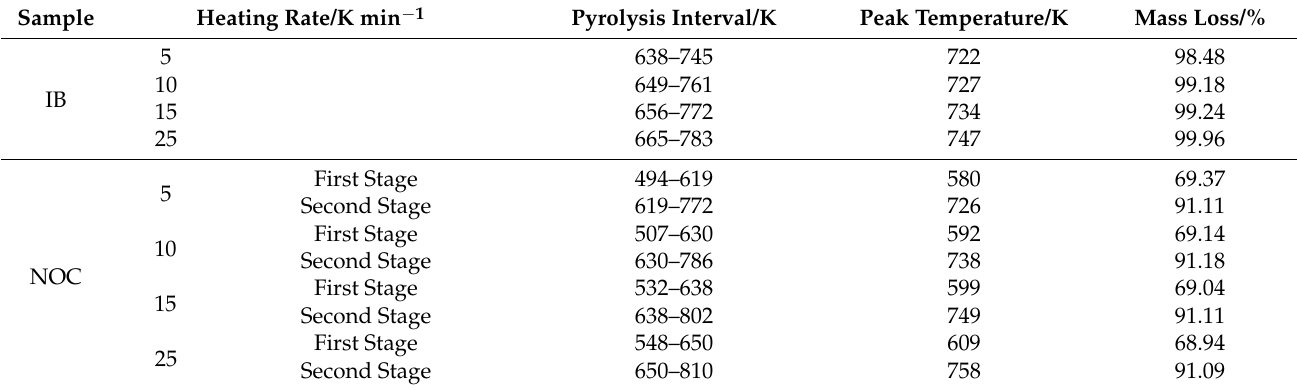
Table 3. Pyrolysis characteristics of infusion bag and nasal oxygen cannula at different heating rates.